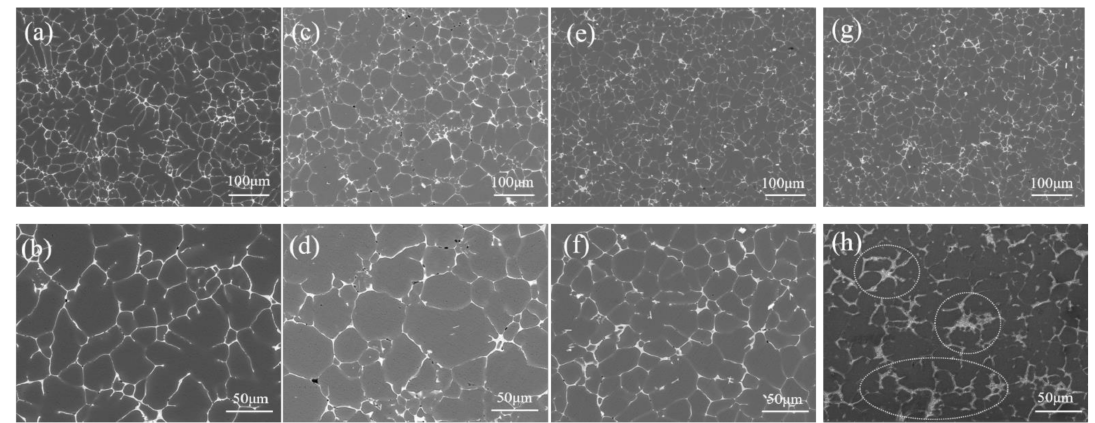
Figure 7. SEM images of ultrasonic treatment and squeeze casting process (UT-SC) alloys with different Zr content: ( a , b ) Alloy A; ( c , d ) alloy B; ( e , f ) alloy C; ( g , h ) alloy